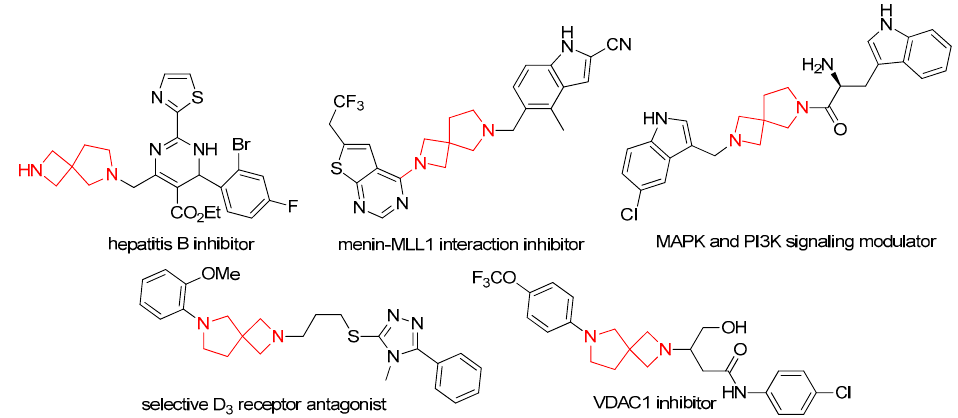
Figure 1. Examples of diverse biologically active compounds containing 2,6-diazaspiro[3.4]octane motif.